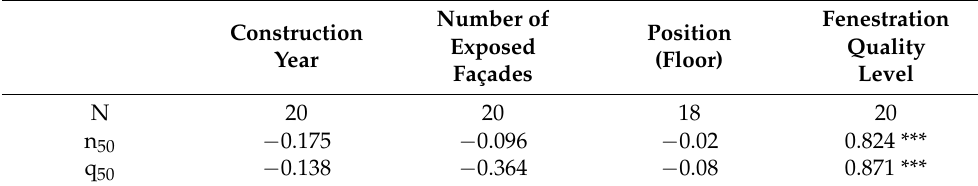
Table 5. The Spearman’s Rho test results show the correlations between the dwelling background conditions and airtightness parameters (n 50 and q 50 ).